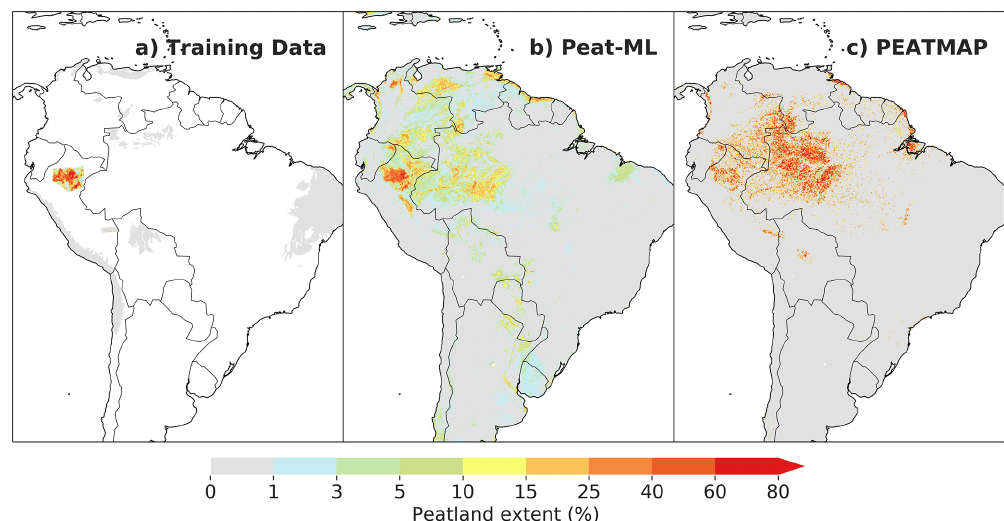
Figure 7. South American peatland extents. Panel (a) shows Peat-ML training data, panel (b) shows Peat-ML-predicted peatland coverage, and panel (c) shows PEATMAP (Xu et al., 2018), which is taken from Gumbricht et al. (2017) for this